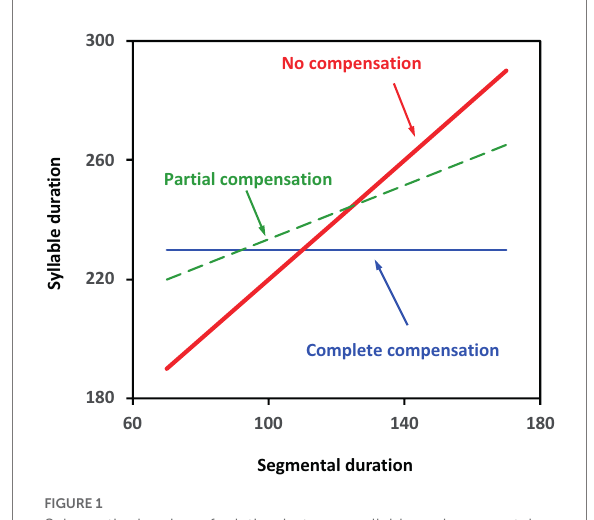
FIGURE 1 Schematic drawing of relation between syllable and segmental duration with complete, partial, or no compensation, where “compensation” refers to how much the duration of a consonant or vowel depends on the identities of the remaining segments in the syllable (adapted from van Santen and Shih,